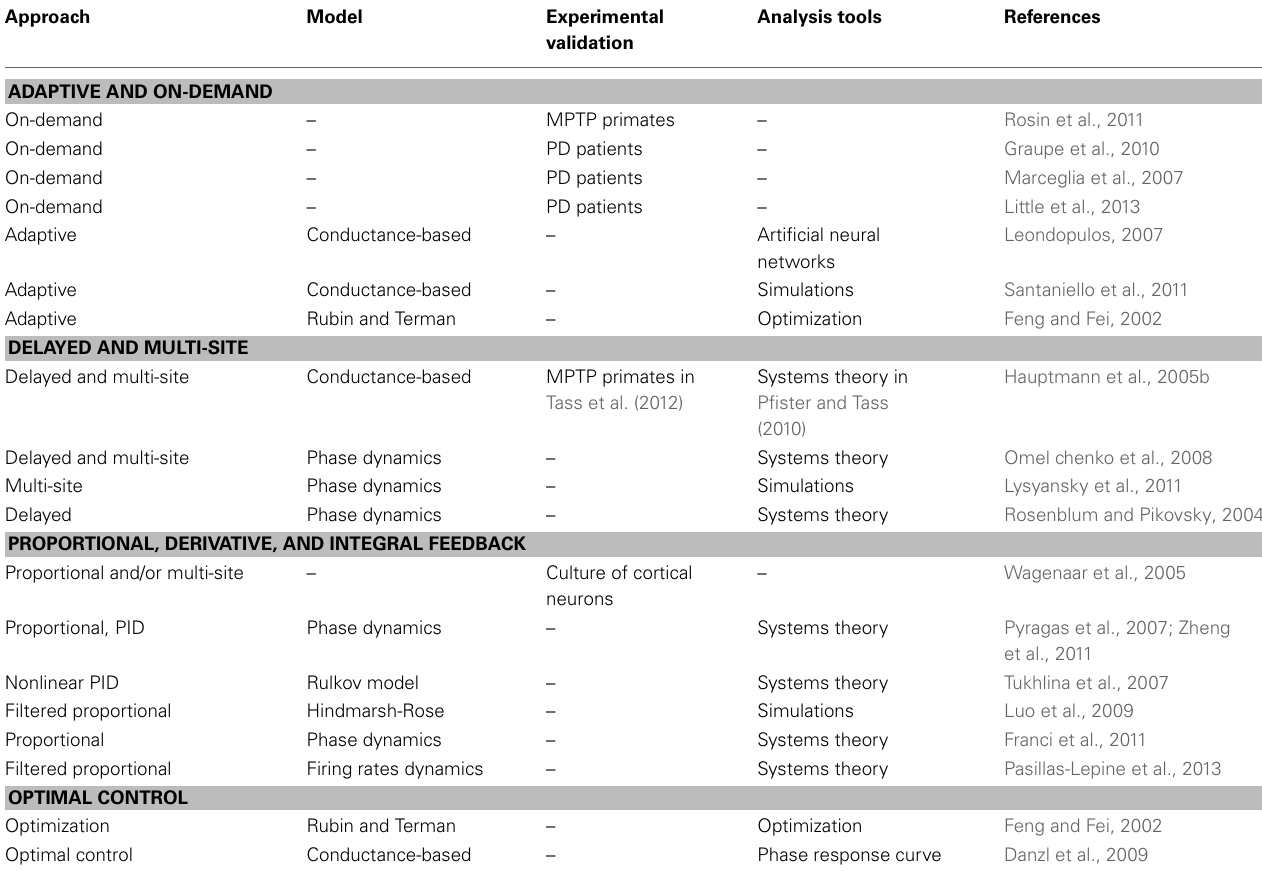
Table 2 | Summarized comparison of closed-loop DBS strategies according to nature of approach, underlying mathematical model (if any), any experimental validation yielded, and overall type of tools (mathematics or simulations)